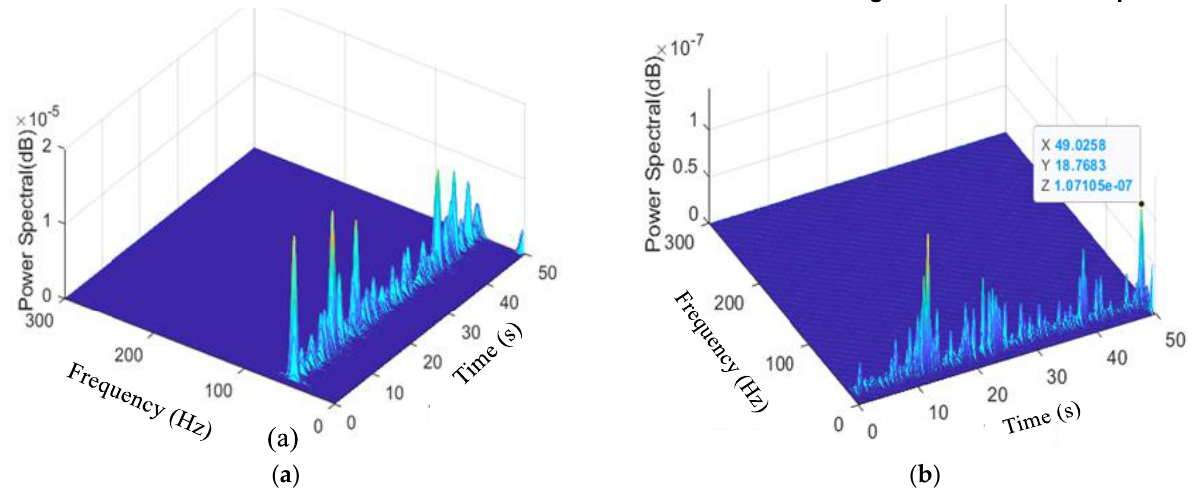
Figure 12. No fluid-NWSST representation of the imbalanced drill string signal in the Y direction. ( a ) Extracted feature from NWSST; ( b ) Extracted impulse feature from NWSST immersed in fluid. Observation 3: Note that the 3D plot scale is different; the high amplitudes of the 1 X and 2 X peaks (t = 0.3 s and 12 s) are lower than the levels observed without fluid